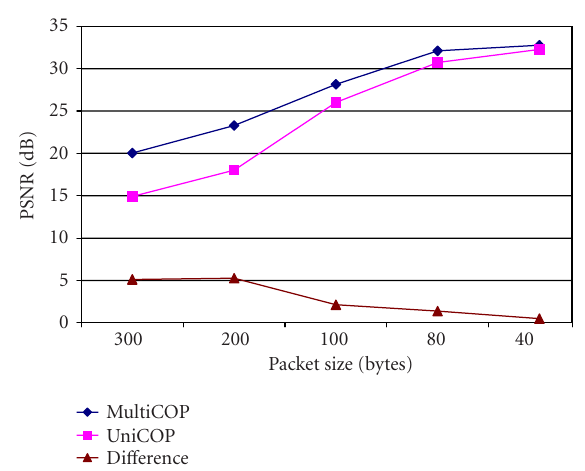
Figure 10: Comparative performance between UniCOP and Multi- COP assignment strategies with (cid:1) = 10 − 4 .